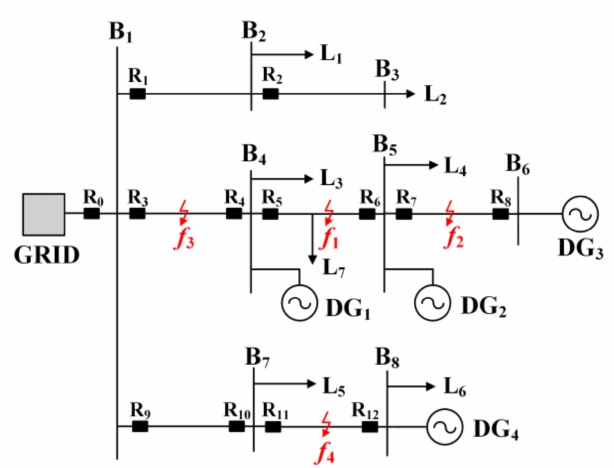
Figure 16. Schematic diagram of the active distribution